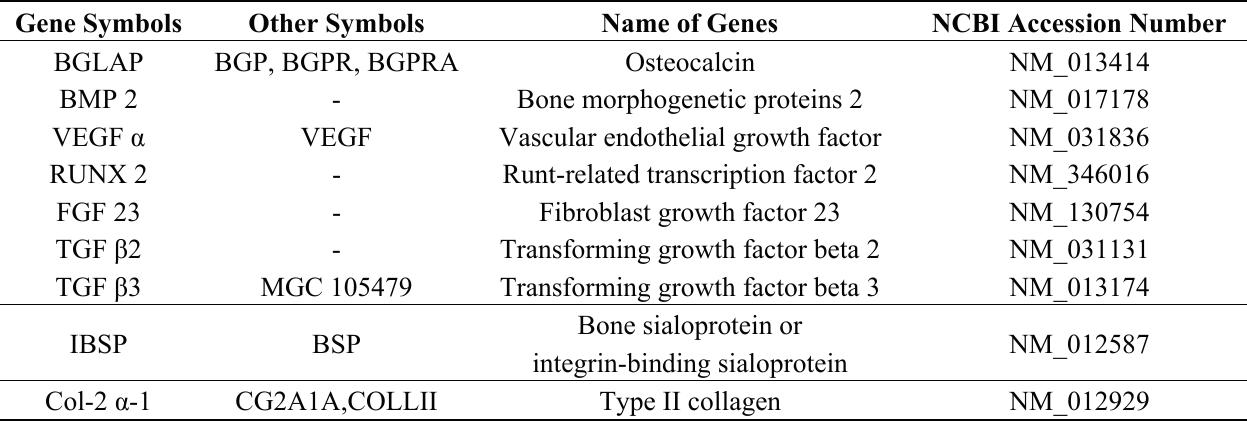
Table 1. Genes of interest measured in this